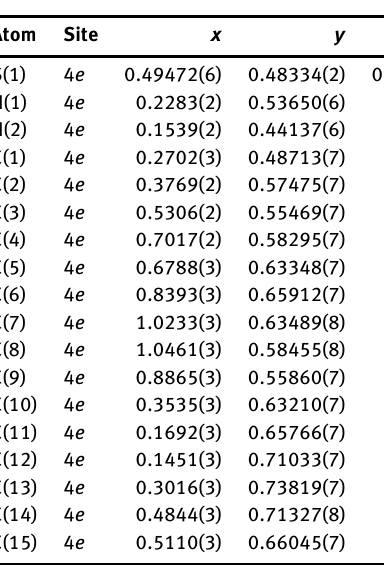
Table 3: Fractional coordinates and atomic displacement parameters (Å 2